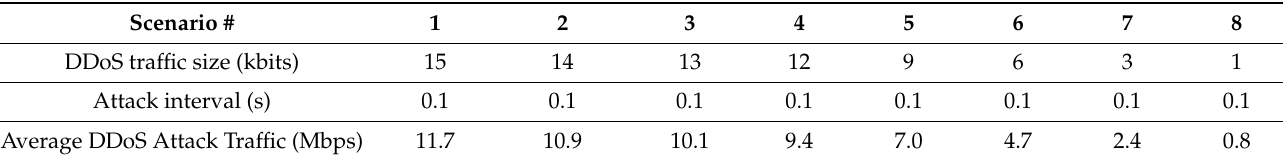
Table 3. DDoS Attack Load for Each